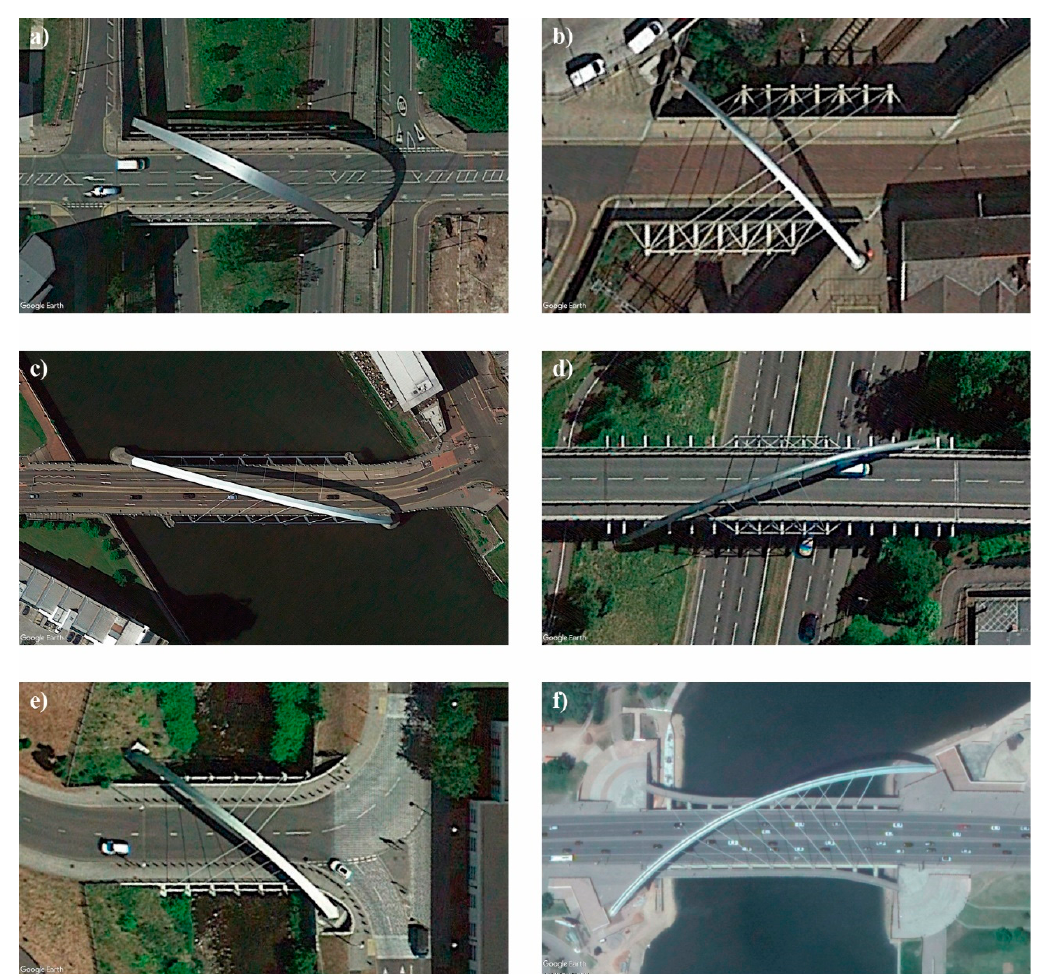
Figure 9. ( a ) Hulme Arch, ( b ) Newport Street Bridge, ( c ) Clyde Arc, ( d ) Gogarburn Bridge, ( e ) River Taff Central Link Bridge, and ( f ) Ramstore Bridge. Photos: Google Earth.